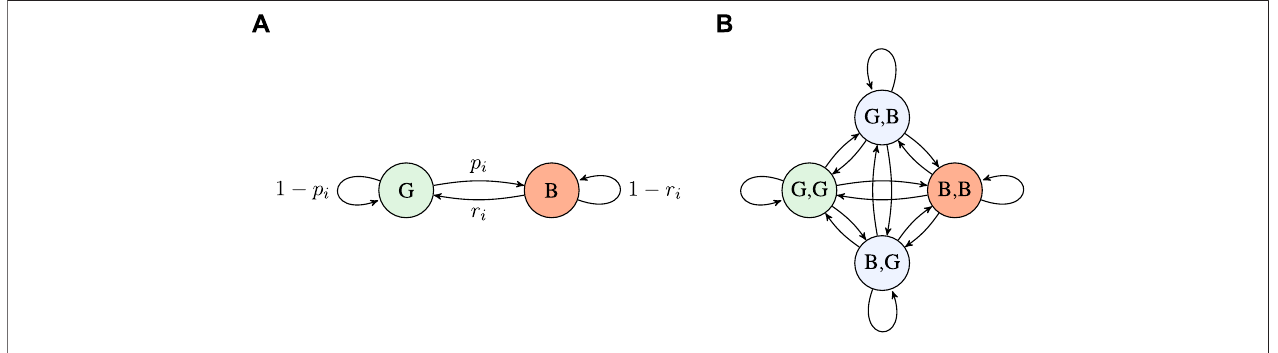
FIGURE 2 | (A) Two-state GE model for an interface i and (B) four-state GE model for a user with two